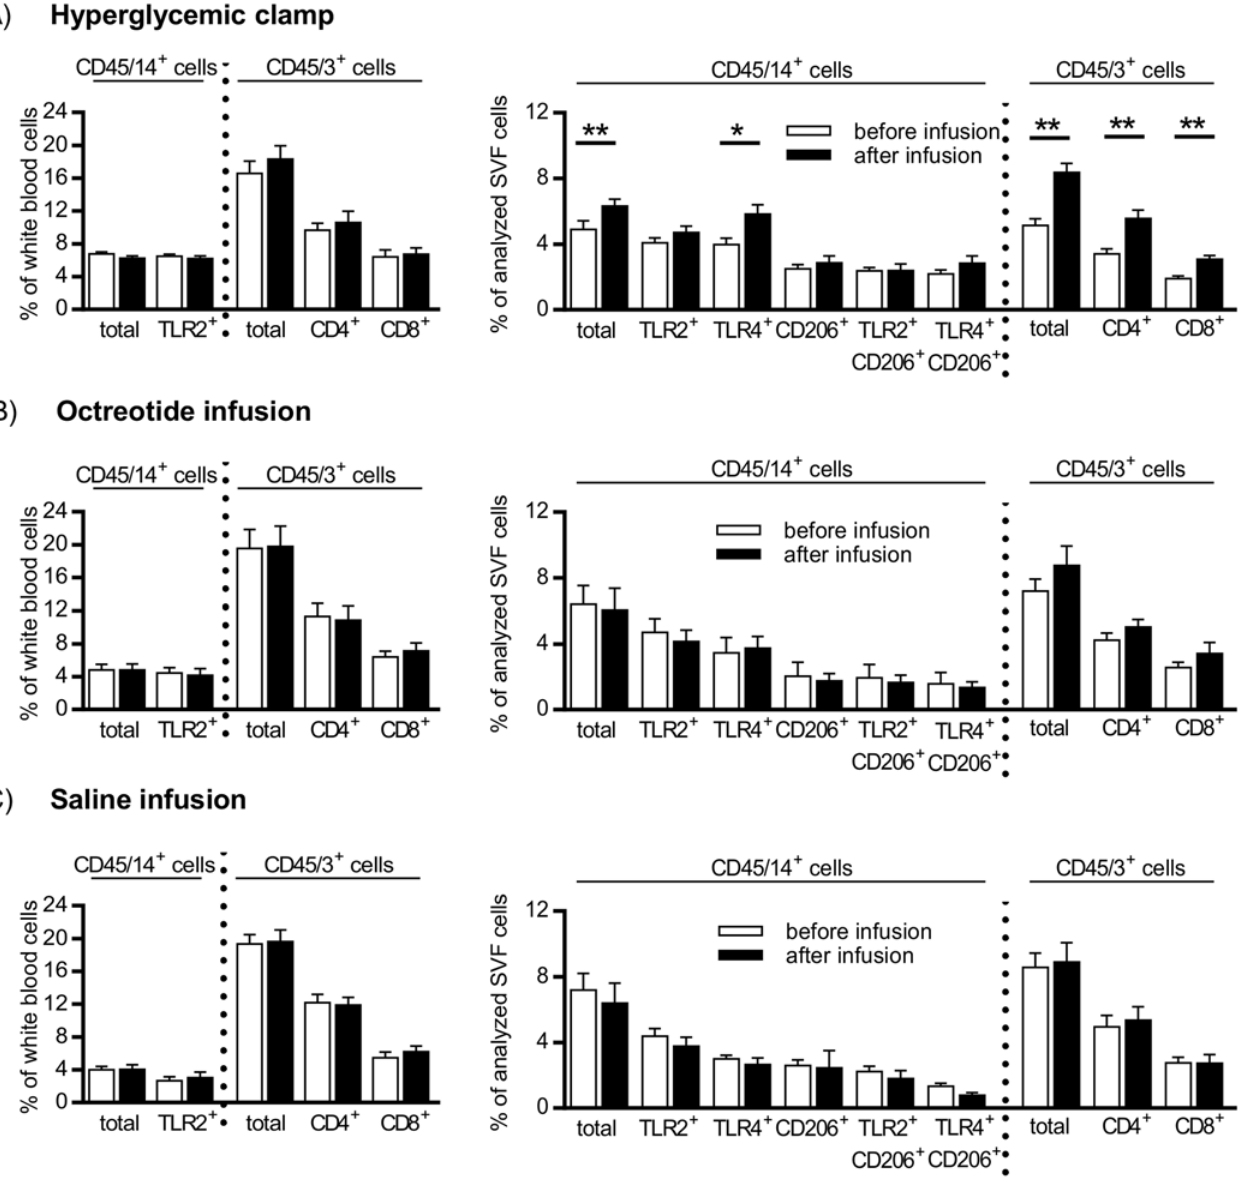
Fig 1. Effect of hyperglycemic clamp (A), octreotide infusion (B), and saline infusion (C) on relative content of monocyte/macrophage and T- lymphocyte populations in peripheral blood and stromal vascular fraction (SVF) of subcutaneous abdominal adipose tissue of obese women. A population of TLR4+ monocytes in blood is not shown due to a low frequency. White bars- before infusion, black bars- after infusion. Data are presented as mean ± SEM, each investigated group n = 10, * p < 0.05; ** p < 0.01: before vs after